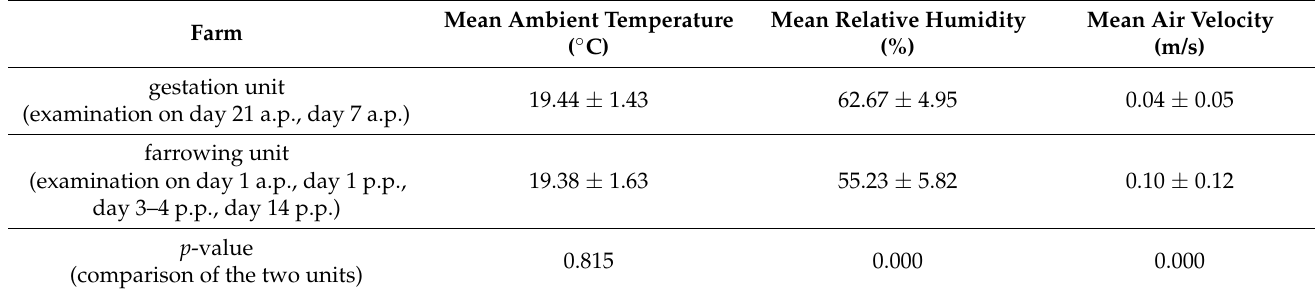
Table 3. Environmental conditions during the follow-up study of sows of different parity.